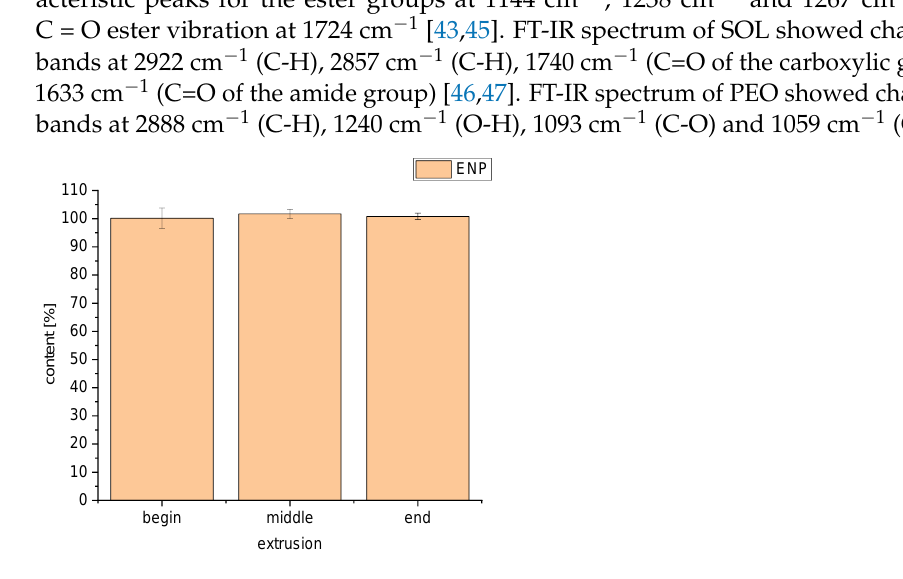
Figure 8. Enalapril and diketopiperazine derivative contents over the extrusion processes at 100 °C